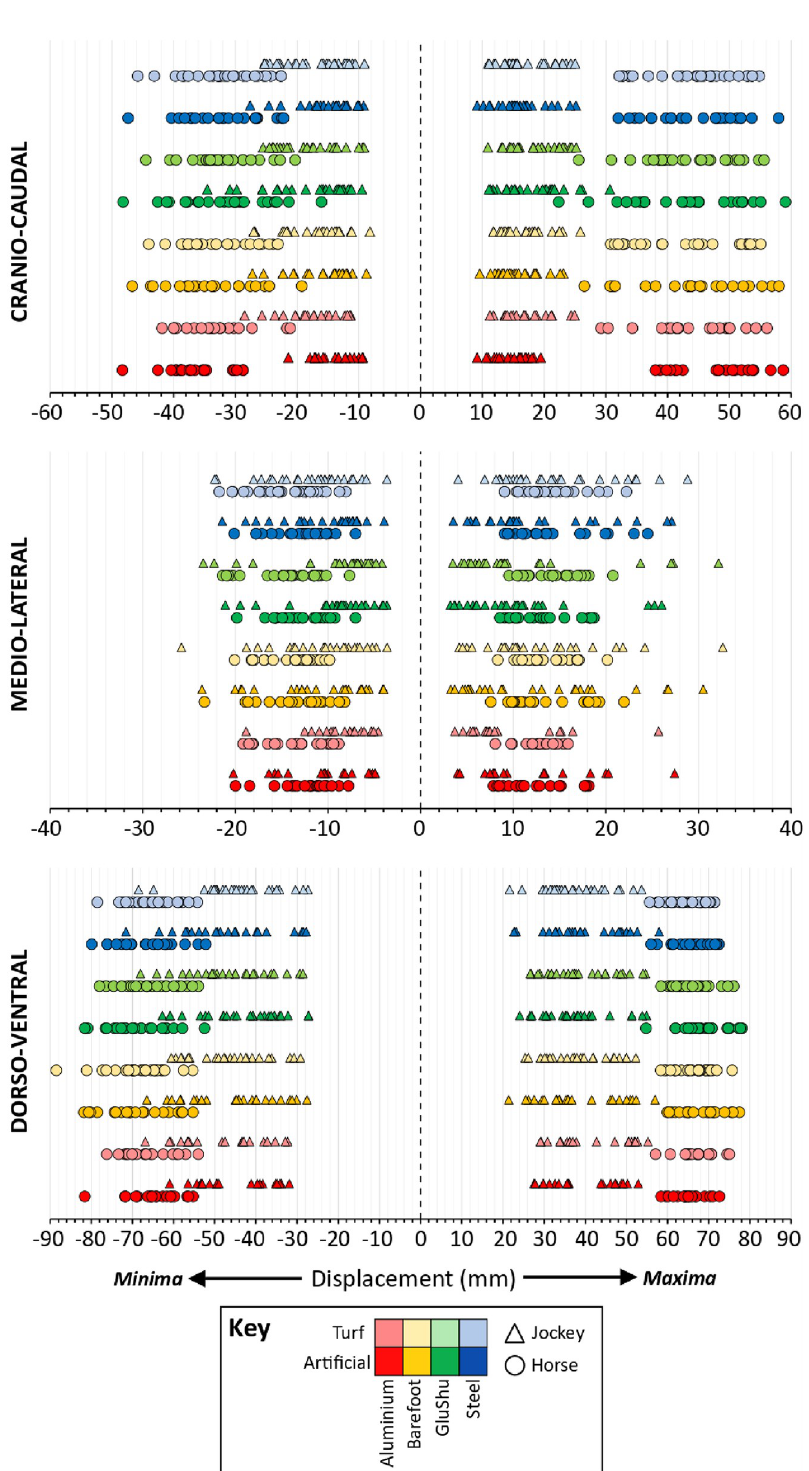
Fig 8. Distribution of displacement minima and maxima values for horse and jockey, sub-divided by shoe-surface combination. This is based on raw mean data of individual runs.